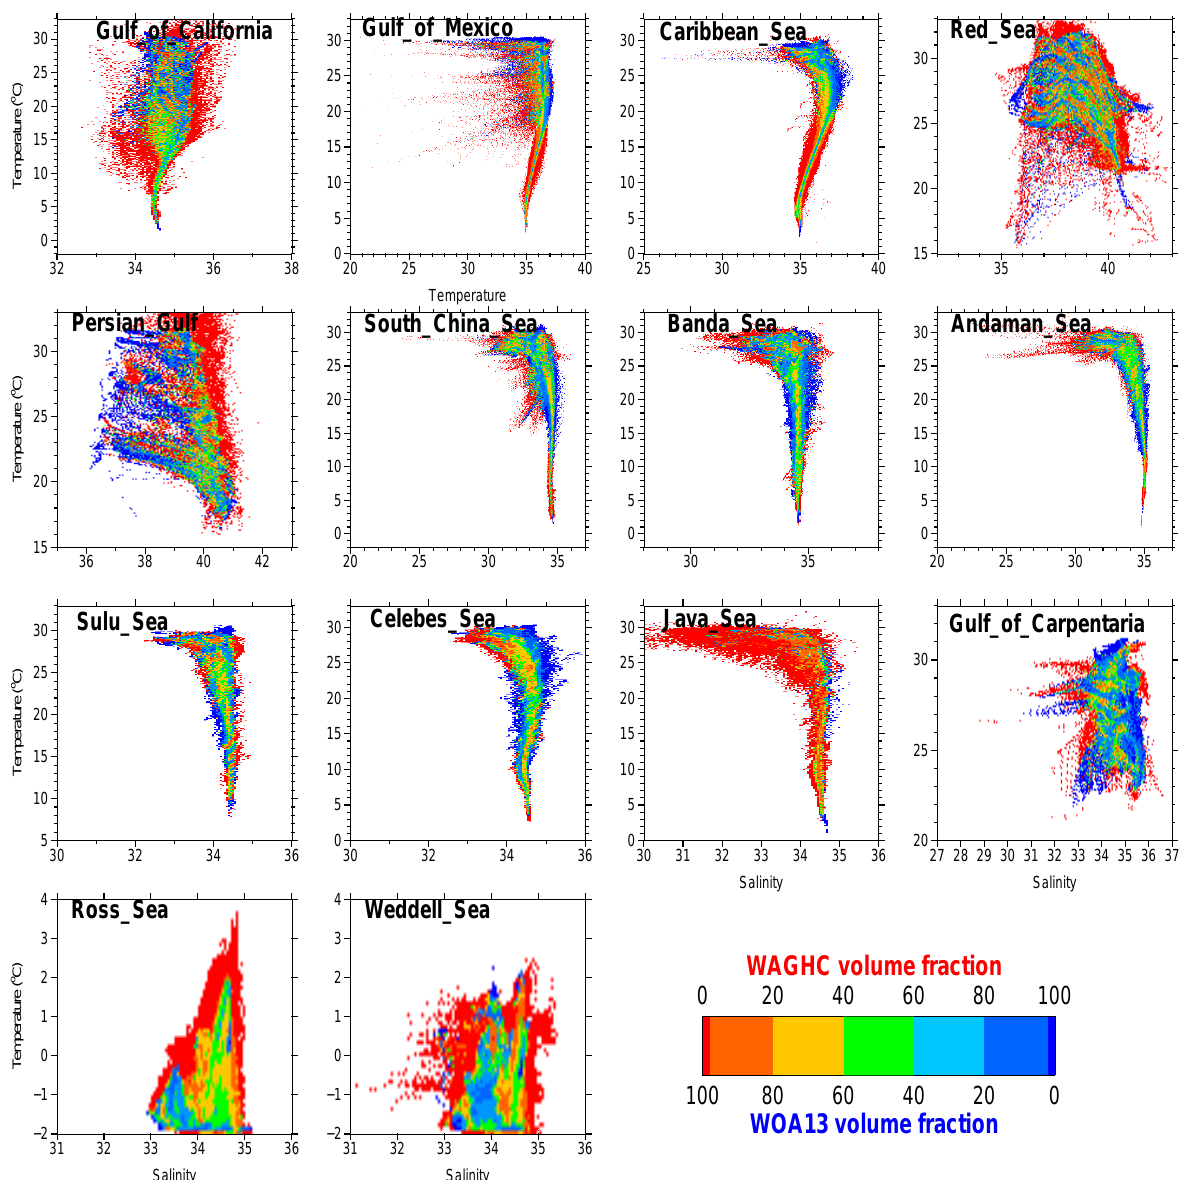
Figure 13. T – S histograms for selected areas of the world ocean (see Fig. 12) for WAGHC and WOA13 gridded climatologies. Bin size is 0.1 ◦ C × 0.05psu. Colors represent the volume fraction of each climatology. Please note that the above figure contains disputed territories.